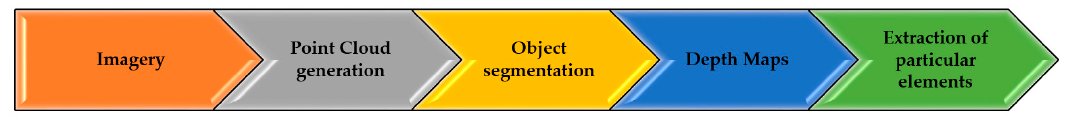
Figure 2. Pipeline for image segmentation.